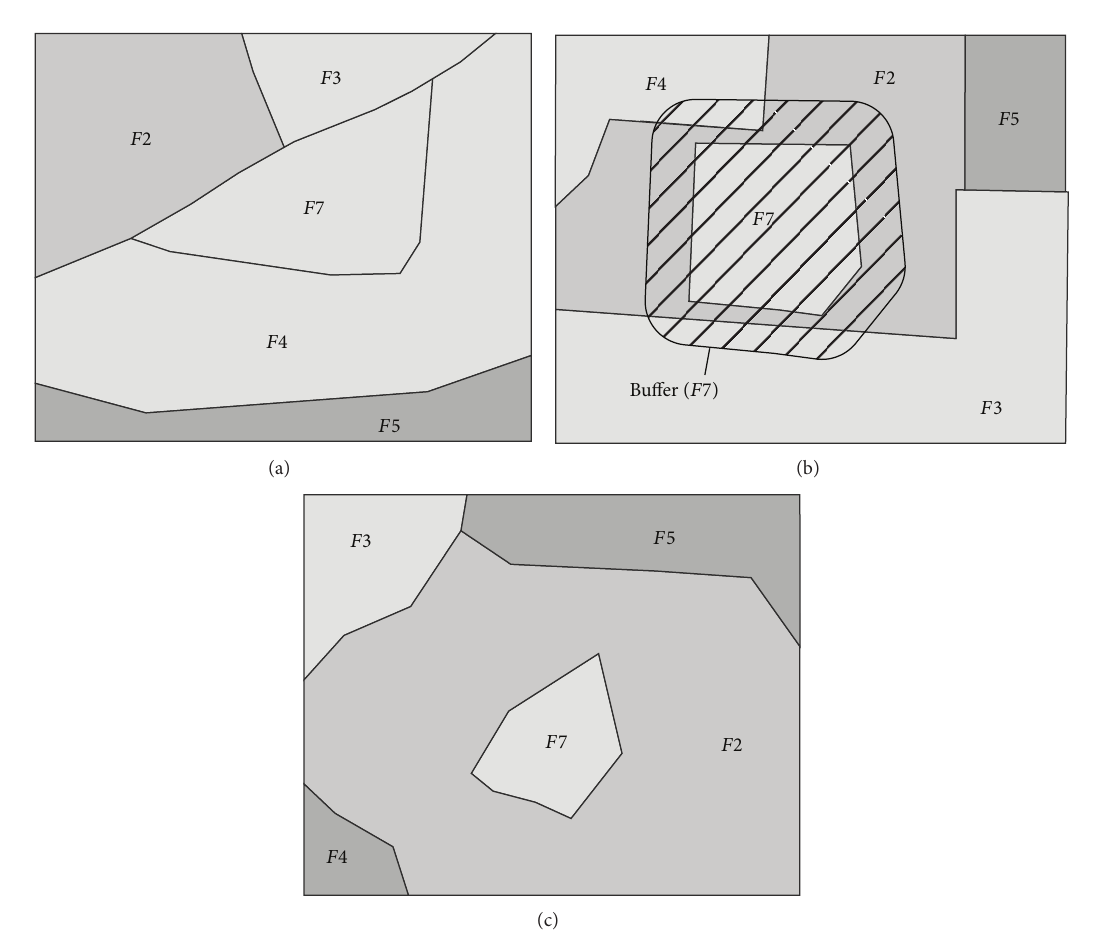
Figure 2: Neighborhood